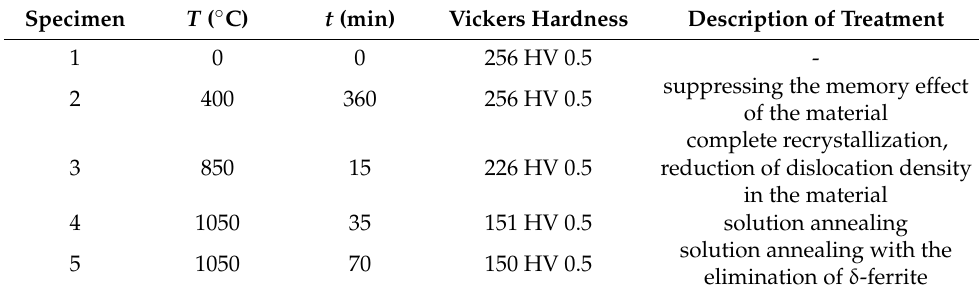
Table 1. Investigated specimens of biomaterial AISI 316L and heat treatment parameters.